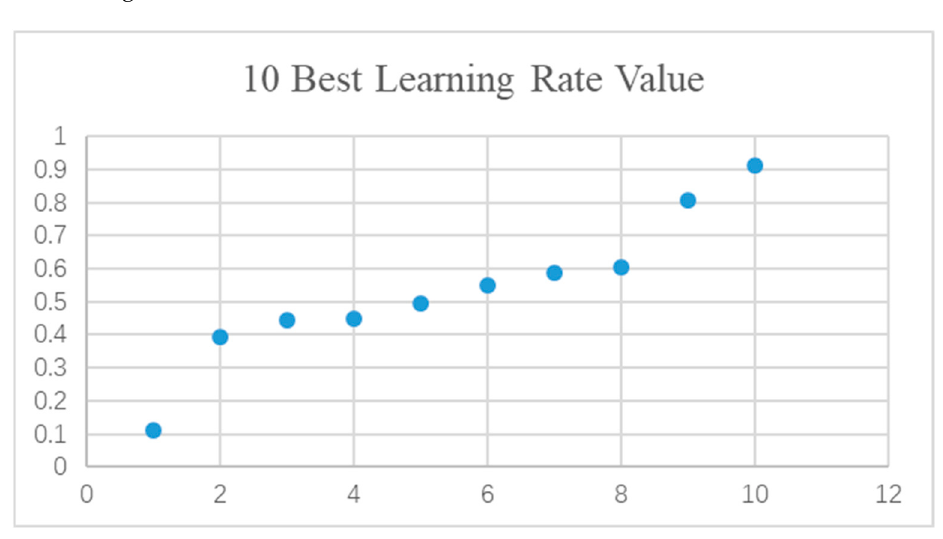
Table 2. GA parameter settings.